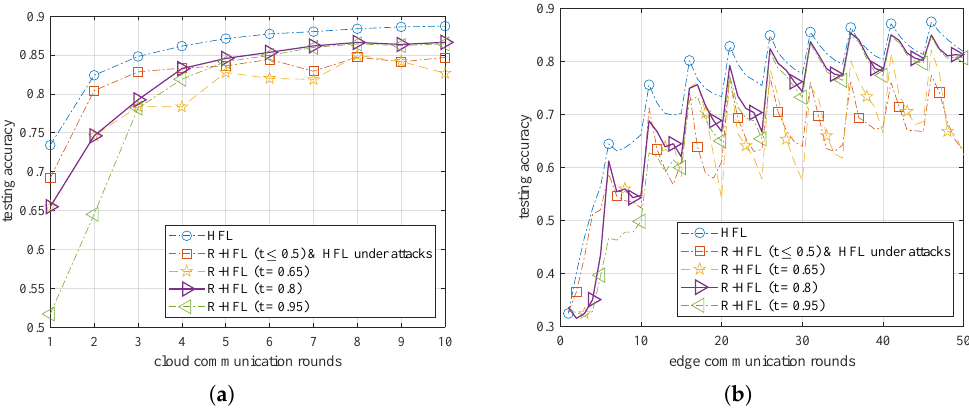
Figure 4. Effect of Threshold t for defending against ANDD attack. ( a ) ANDD: global model performance varying with t , ( b ) ANDD: edge model performance varying with t .